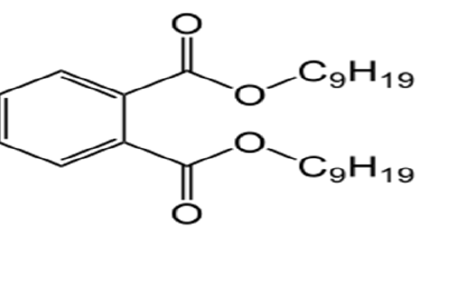
Chemical Structure of Diisononyl phthalate (Bis(7- methyloctyl) benzene-1,2-dicarboxylate)